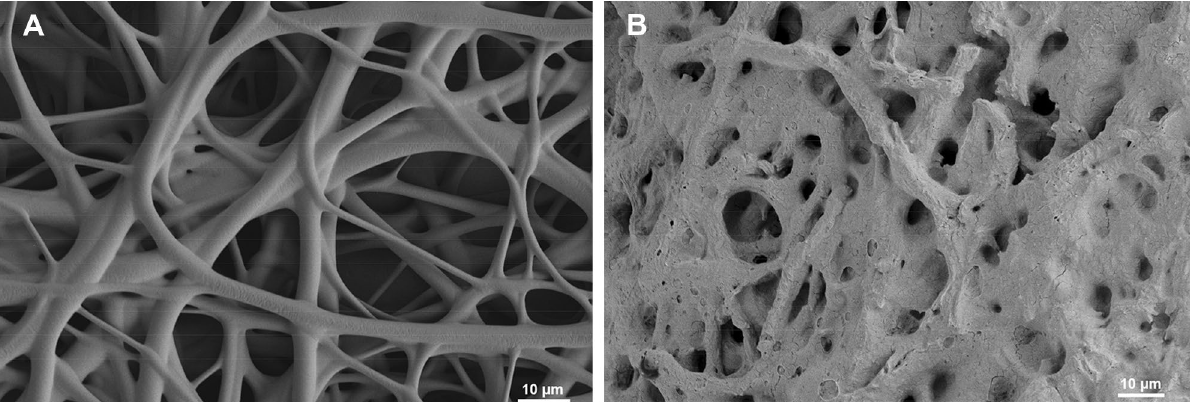
Figure 1. SEM images of electrospun DP fiber mesh freshly produced ( A ) and after 12 weeks in vivo as implant material intended to reduce adhesion formation ( B